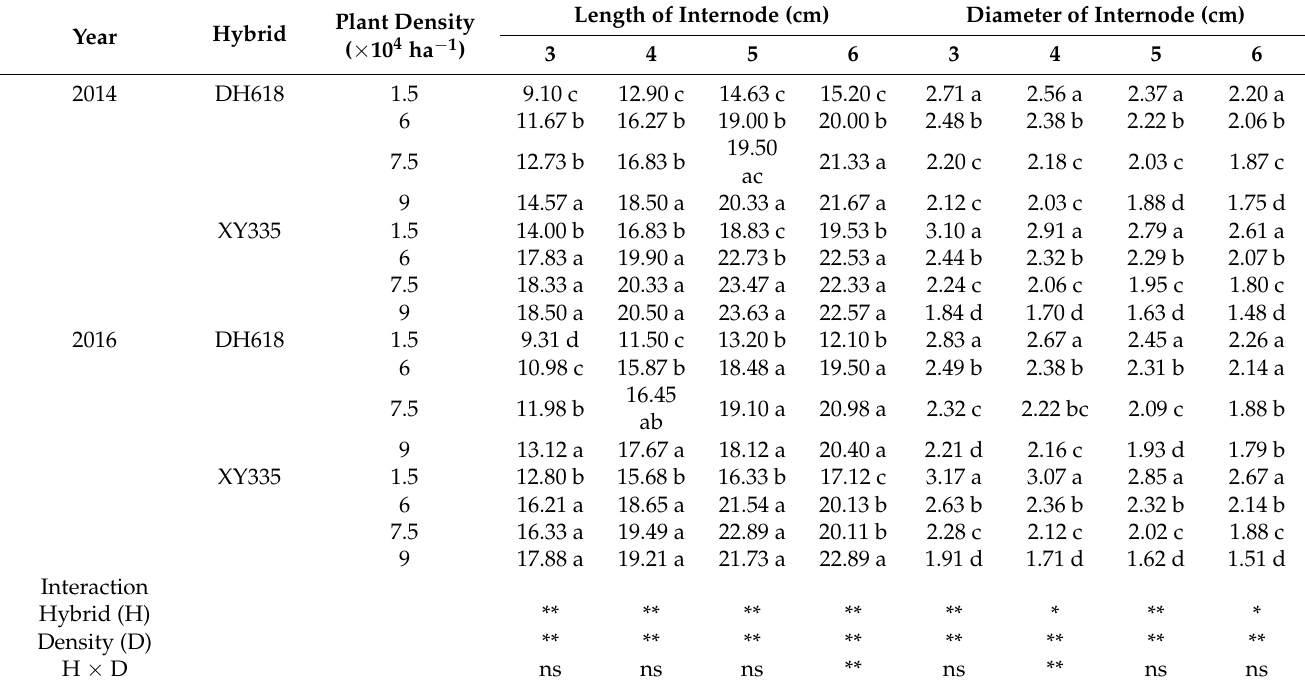
Table 5. Length and diameter of internode of DH618 and XY335 under different planting densities in 2014 and